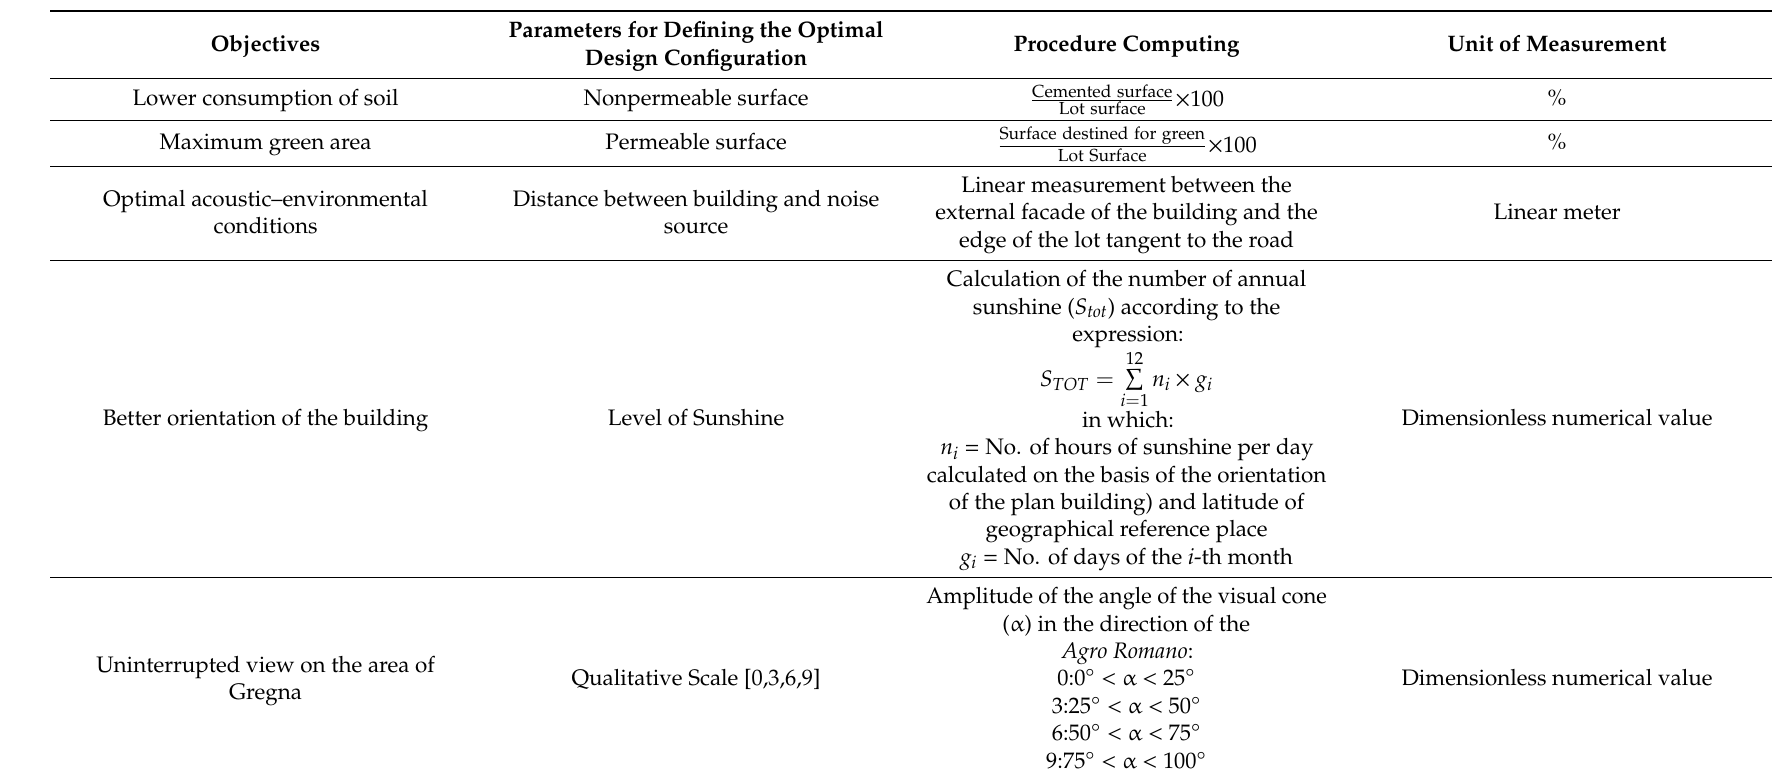
Table 4. Parameters for the optimal design